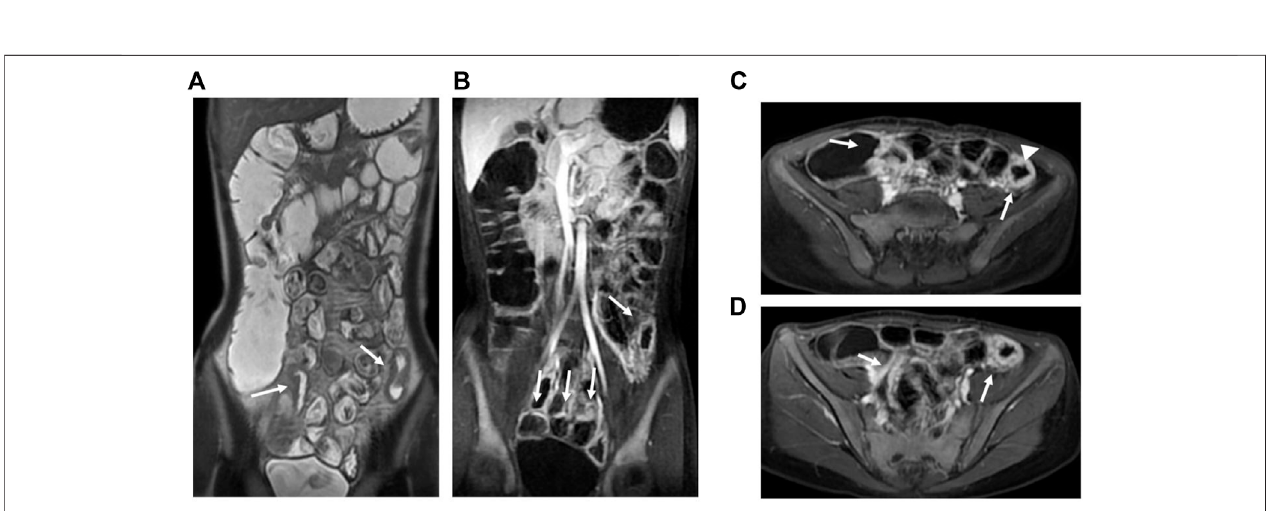
FIGURE 3 | MRE image: Bowel wall thickening in the terminal ileum and the left hemicolon with increased mural signal intensity (arrow in A). Coronal (B) and axial (C,D) : Asymmetric bowel wall thickening (arrow in B, C, and D). Luminal ulcerations (arrowhead in C).